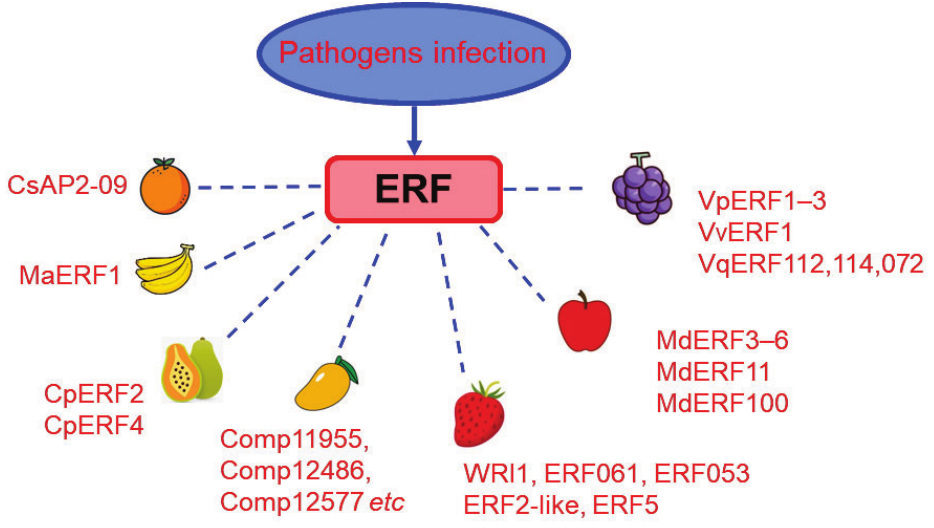
Figure 6. ERF factors functioning in pathogen response in various fleshy fruits. Multiple ERF factors have been identified in different fruits, including citrus (CsAP2-09), banana (MaERF1), papaya (CpERF2, CpERF4), Mango (Comp11955, comp12486, Comp12577 etc.), strawberry (WRI1, ERF061, ERF053, ERF2-like, ERF5), apple (MdERF3–6, MdERF11, MdERF100), grape (VpERF1–3, VvERF1, VqERF112, VqERF114, VqERF072). Further details are described in Section 3.5. Results for tomato are shown in Figure